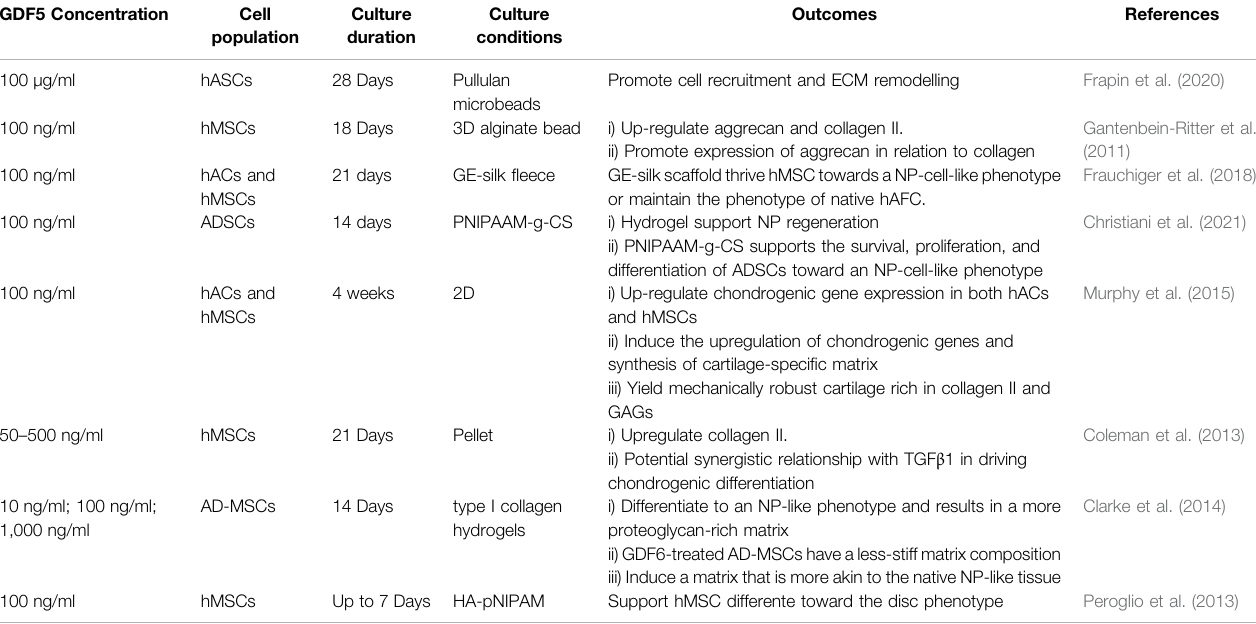
TABLE 1 | Effect of GDF5 on MSCs in culture.